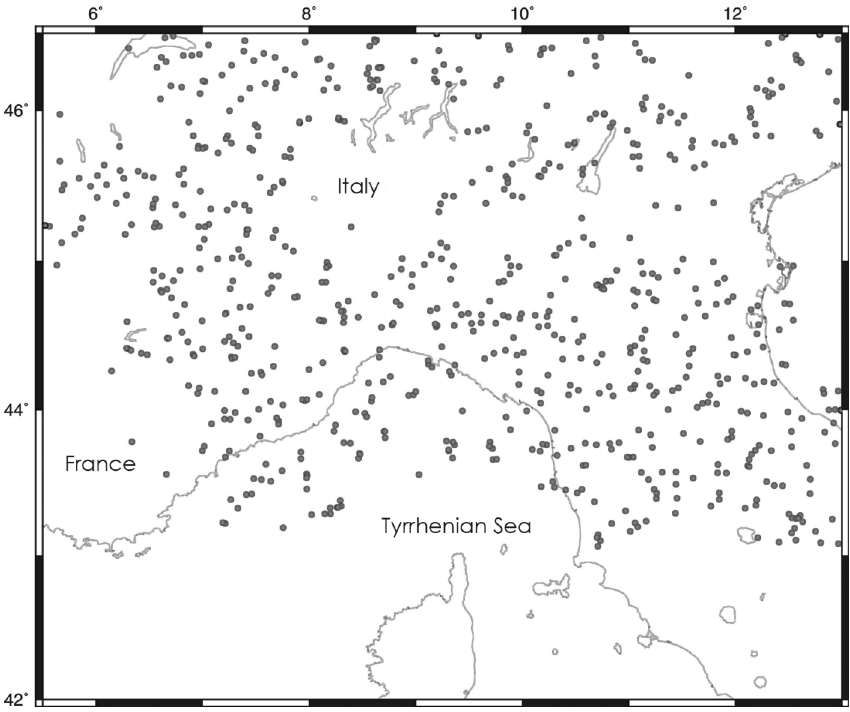
Fig. 2. Earthquakes used for the computation of the reference model applied in this work. They cover the pe- riod